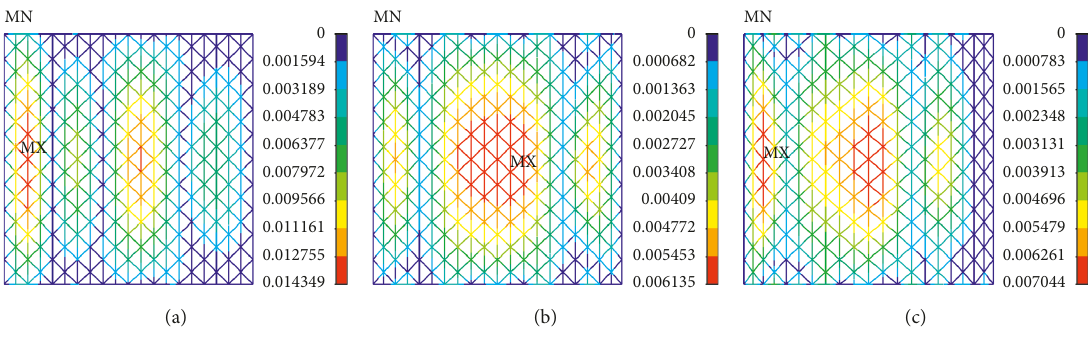
Figure 14: The response displacement distributions on single-layer reticulated cylindrical shells with different rise-to-span ratios. (a) R / S � 1/10. (b) R / S � 1/6.25. (c) R / S � 1/4.